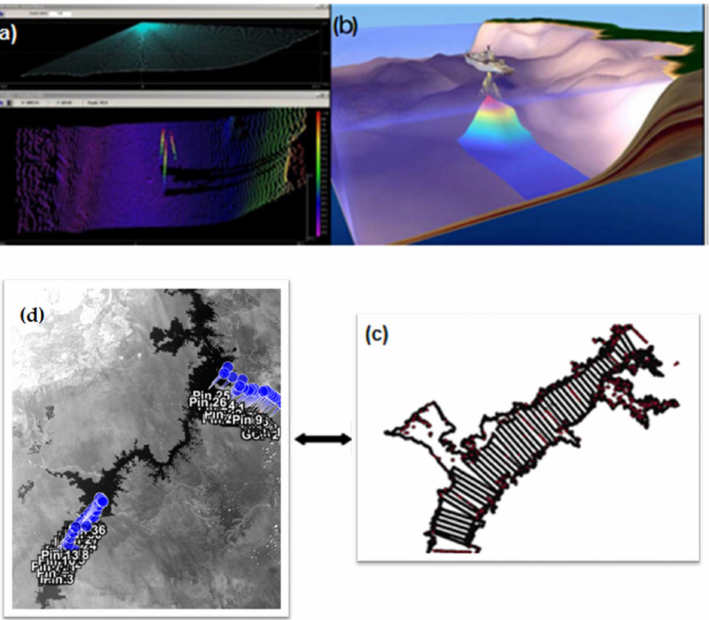
Figure 2. ( a , b ) show the use of new survey technology and the multi-beam echo sounder to determine the depth [25]; ( c ) shows paths of a bathymetric field trip in the study area, and ( d ) shows the locations of the bathymetry points used in building the bathymetry model.